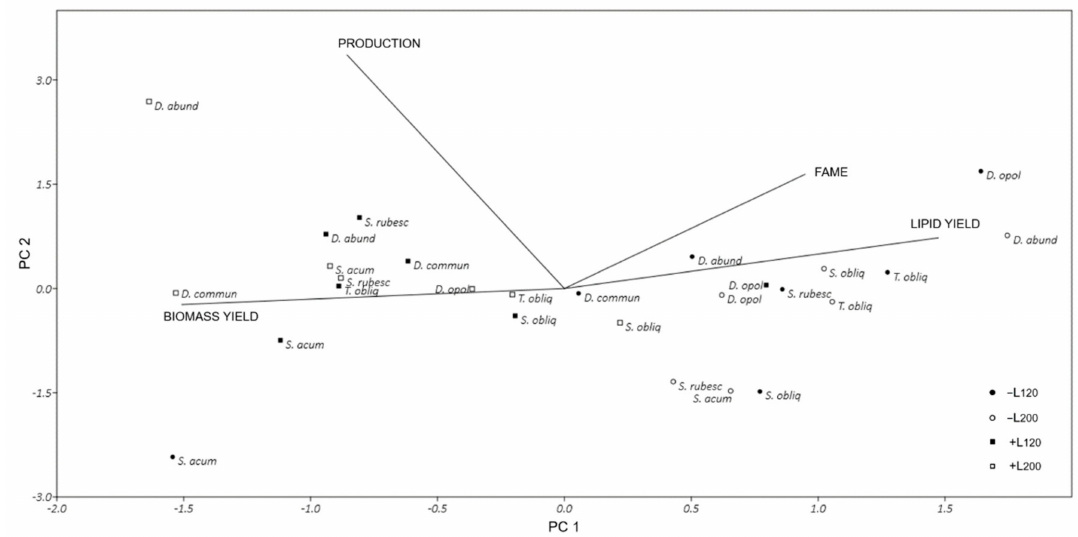
Figure 5. Principal component analysis (PCA) performed on a correlation matrix evidencing the relationships among observations (all the strains in all culture conditions) and variables. Biomass means dry weight as grams; production means biomass production as gDW L − 1 ; lipid yield and FAME expressed as %. − /+ indicated the absence / presence of N in BBM medium.